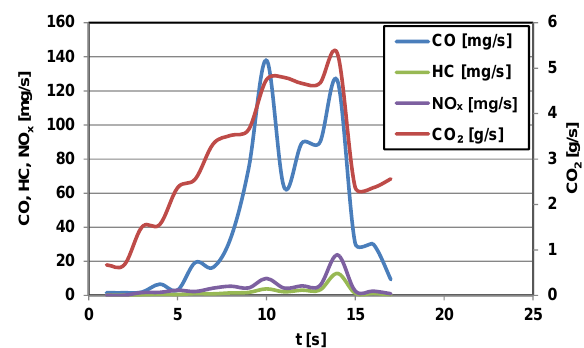
Fig. 10. Emission rates of individual exhaust gas components as a function of simulation time for: a = 1.2 m/s 2